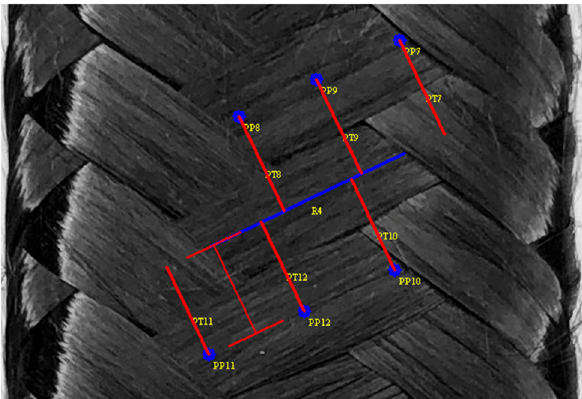
Figure 7: Schematic diagram of multi - point measurement method of yarn